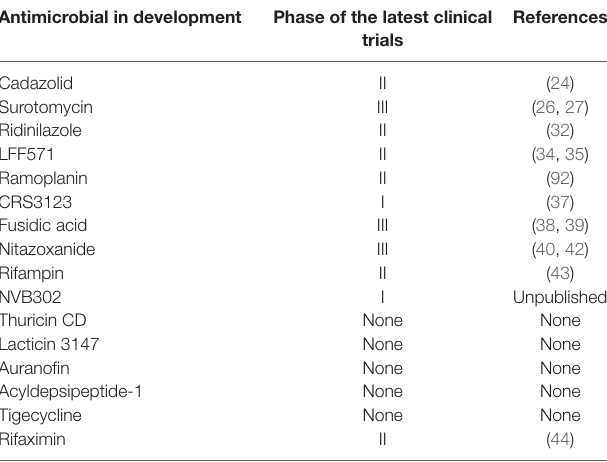
TAbLe 2 | Phase of the latest clinical trials for the novel antimicrobial in development for CD. Antimicrobial in